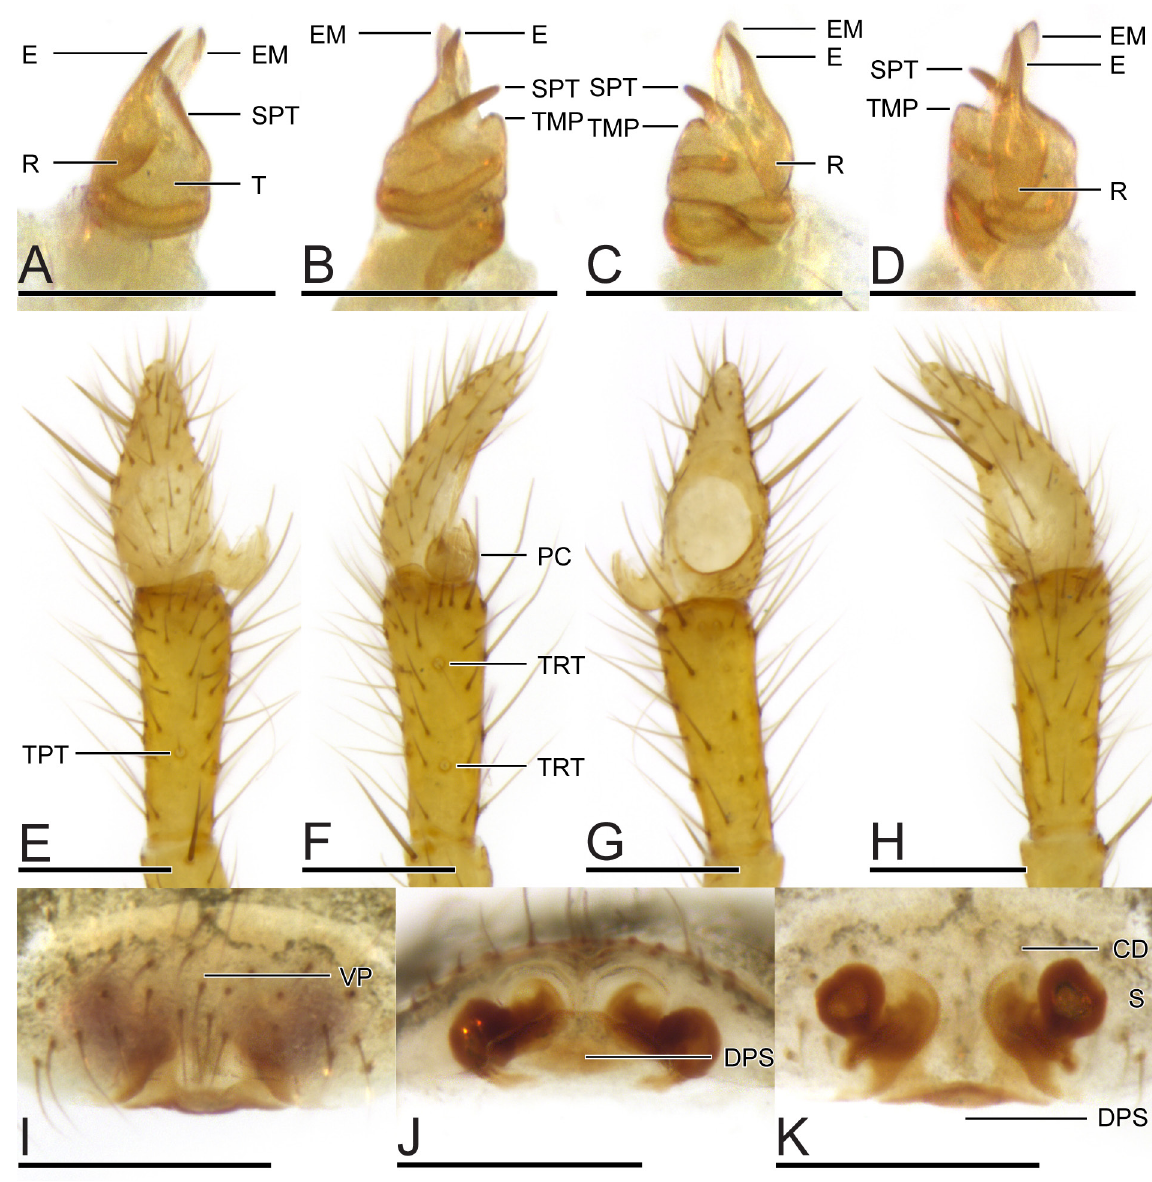
Fig. 7. Afroneta elgonensis Merrett, 2004. A–H . Allotype, ♂ (UPSZMC 67572). A . Left bulbus (mirrored), dorsal. B . Retrolateral. C . Ventral. D . Prolateral. E . Left palp (mirrored), dorsal. F . Retrolateral. G . Ventral. H . Retrolateral. I–K . ♀ (UPSZMC 67572). I . Epigyne ventral. J. Aboral. K. Dorsal. Scale bars: 200